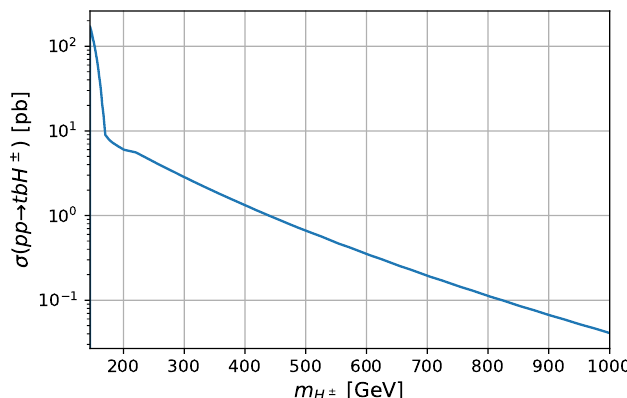
Figure 6. Charged Higgs production cross section in the pp → H ± tb channel at the 13 TeV LHC for tan β = 1 at NLO [142,